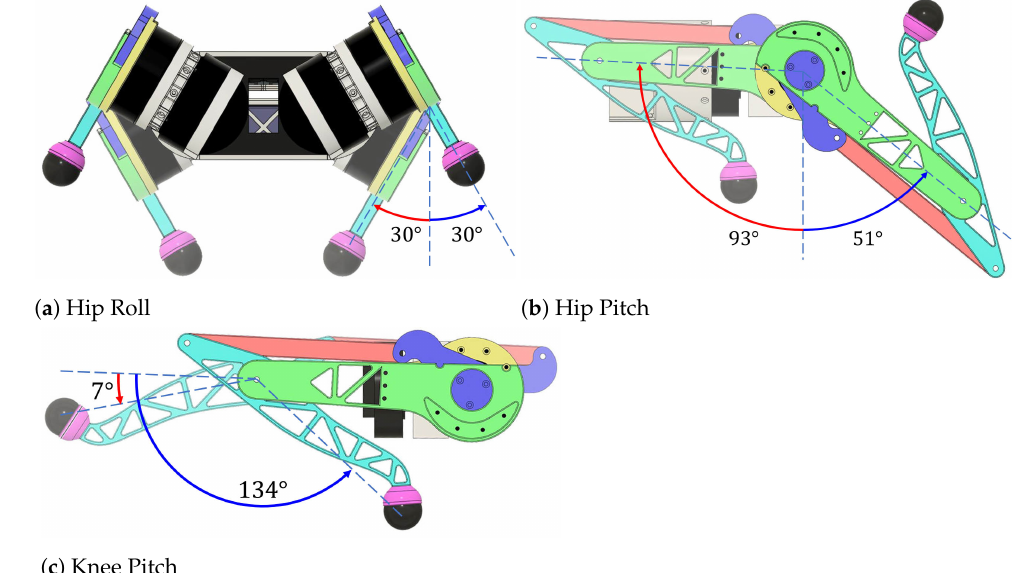
Figure 7. Joint ranges of three leg